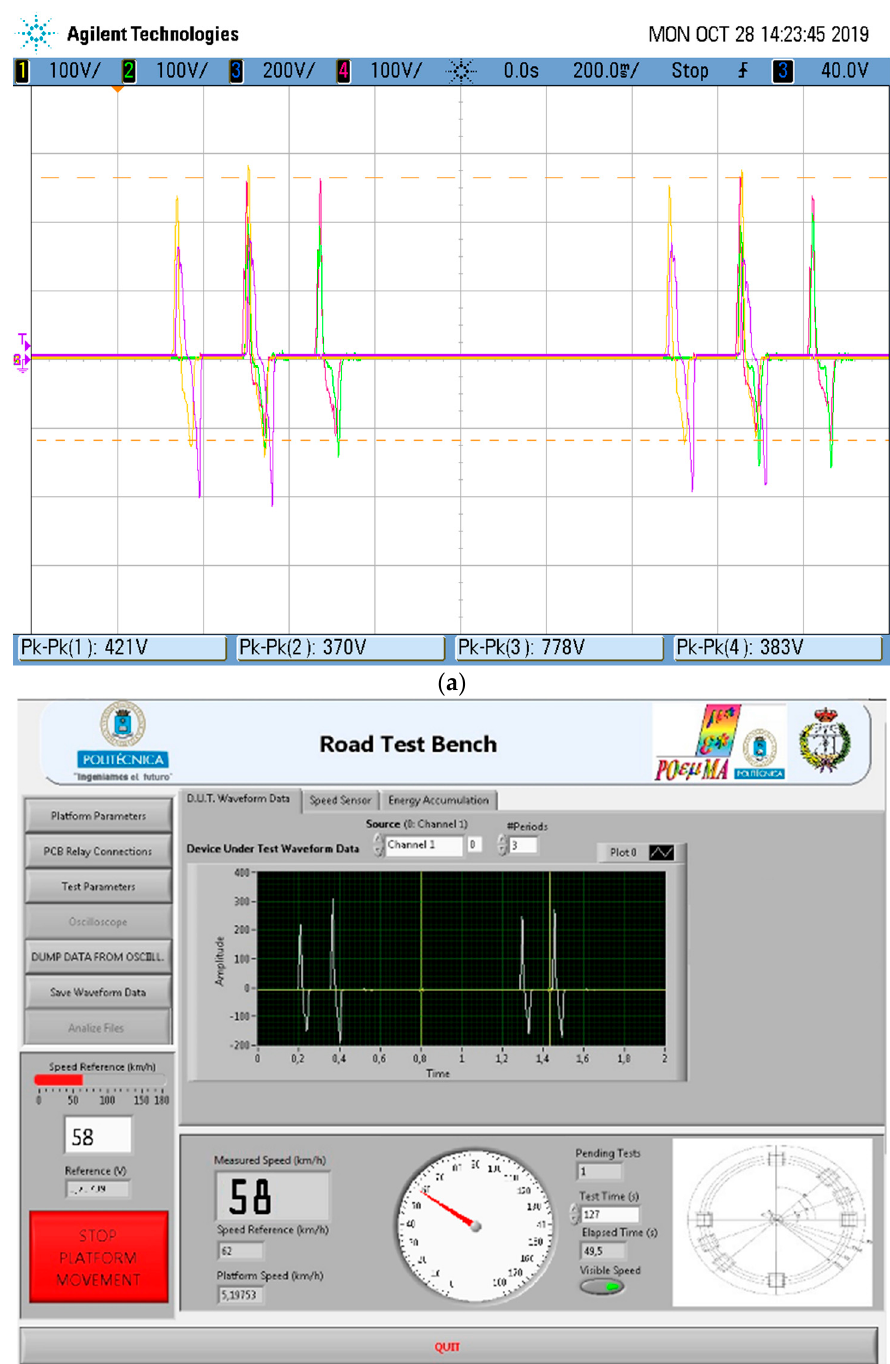
Figure 3. ( a ) Piezoelectric electrical signals from four lead-containing lead zirconate titanate (PZT) piezoelectric devices under test (PDUTs). ( b ) Software interface acquiring one channel of electrical PDUT response to obtain the active electrical model.